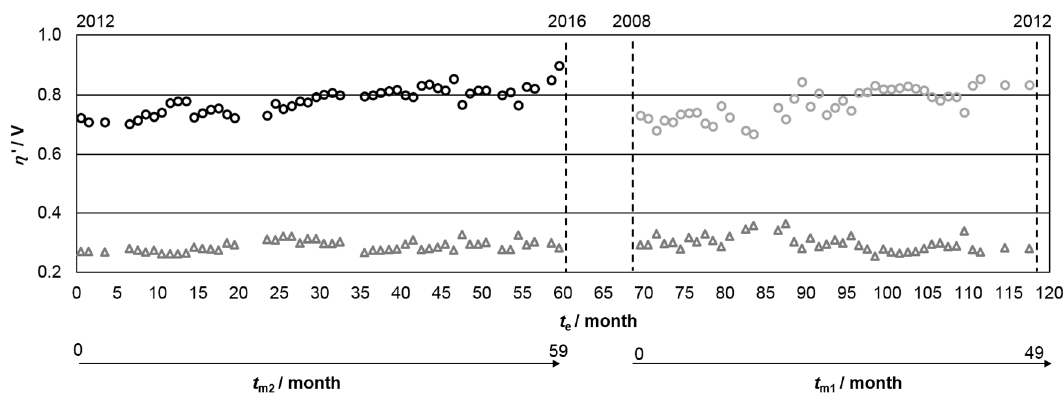
Figure 5. Activation ( Δ ) and ohmic overpotentials ( ○ ) as a function of the electrode and membrane service times, respectively t e and t mi .